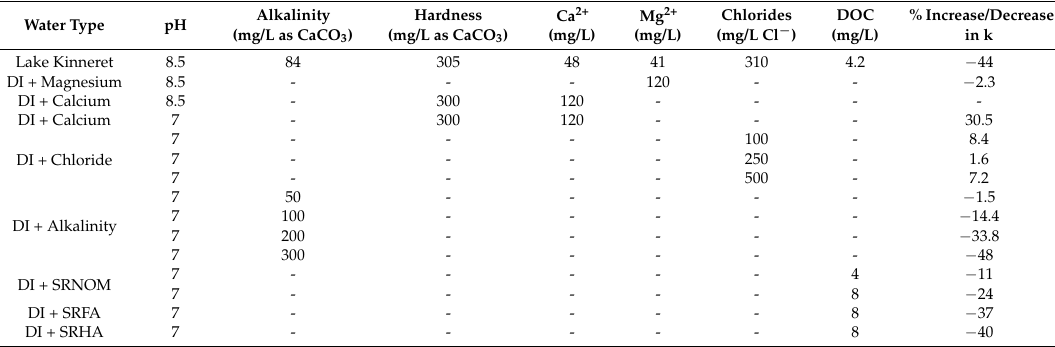
Table 4. Summary of water type and composition effect on photocatalytic degradation reaction